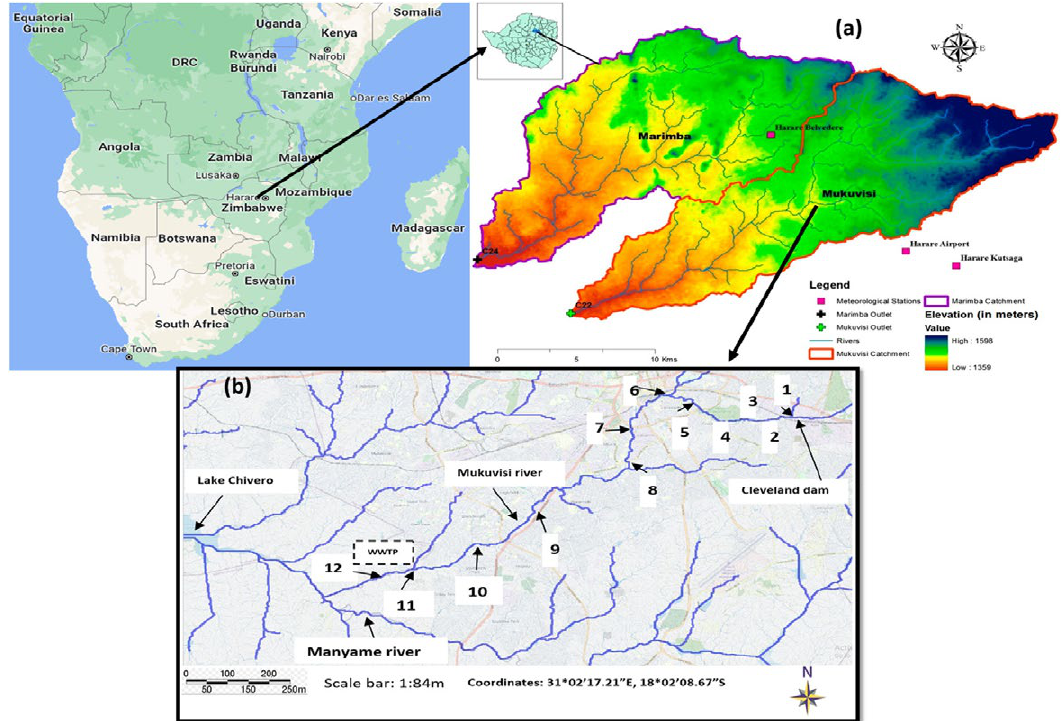
Fig. 1 : 1a, a detailed aerial view of Mukuvisi River showing the sampling sites; 1b, show DEM for Mukuvisi River catchment (Google, 2022: Gumindoga et al ., 2014).